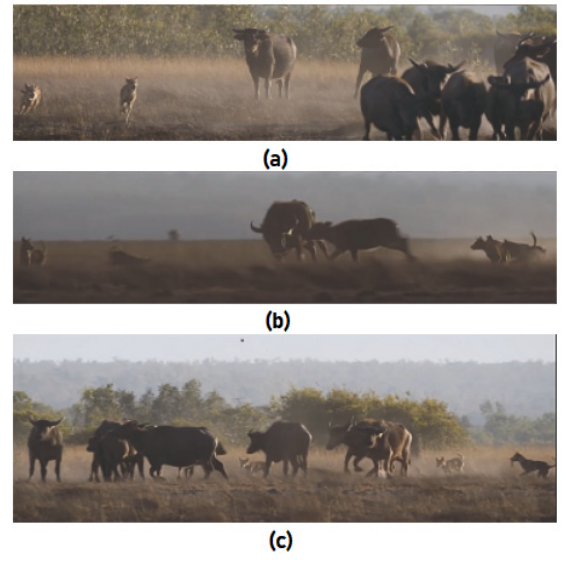
Figure 1. Hunting behavior of dingoes: (a) chase and approach the prey, (b) encircle and harass the prey, (c) attack and hunt down the prey The pack is led by its most dominant member, male or female. Their responsibility is to make decisions for the pack, select sleeping places, and lead the hunt. The second level in the hierarchy is the beta dingo, which is the mediator between the alpha and the rest of the pack. Also, if the alpha dies, the beta takes over his